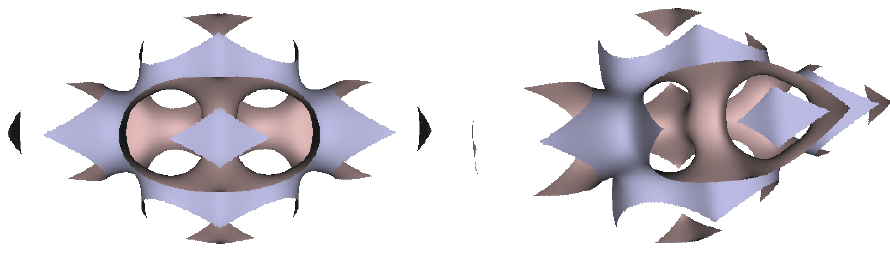
Figure 9. Two views of the TIS D-surface generated from two connecting